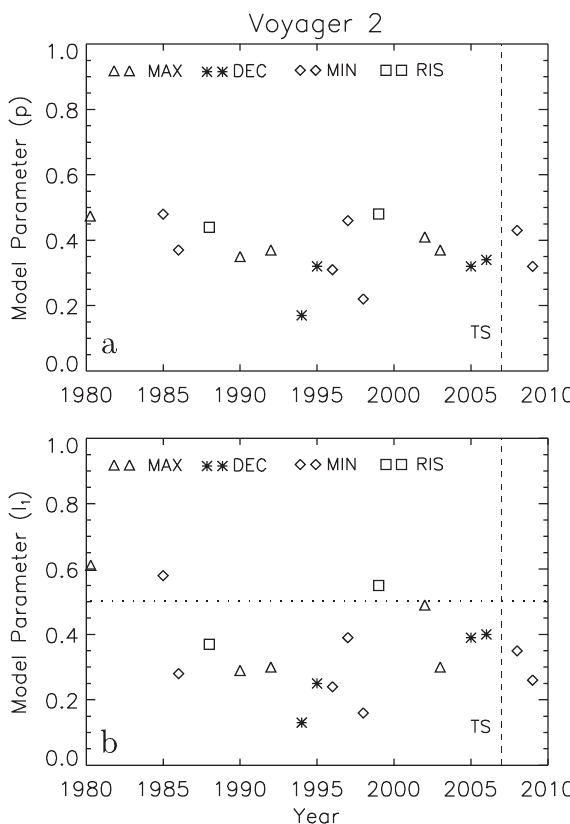
Fig. 6. Evolution of both parameters (a) weight p and (b) scale l 1 of the generalized Cantor set model ( p ≤ 0 . 5, l 1 + l 2 ’ 1) obtained during solar minimum (MIN) and solar maximum (MAX), and de- clining (DEC) and rising (RIS) phases of solar cycles (at various he- liospheric distances and latitudes). The value l 1 = 0 . 5 corresponds to the one-scale symmetric model (dotted). The crossing of the ter- mination shock by Voyager 2, TS, is marked by a vertical dashed line.